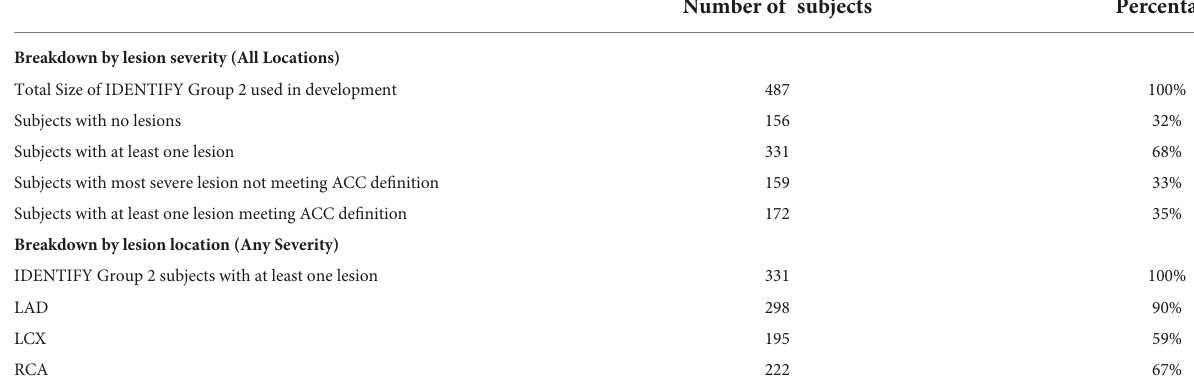
TABLE 3 Spectrum of disease observed in the population used for algorithm